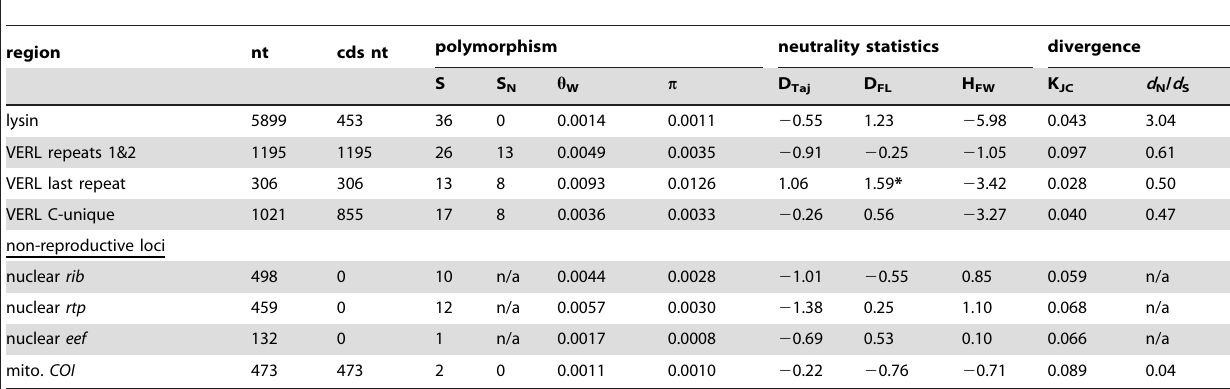
N=28 individuals. nt=nucleotides, cds=coding sequence, S=polymorphic sites, S N =nonsynonymous polymorphic sites, h W =Watterson’s theta, p =nucleotide diversity, D Taj =Tajima’s D, D FL =Fu & Li’s D, H FW =Fay & Wu’s H, an asterisk( * ) denotes statistical significance at a =0.05, K JC =Jukes-Cantor corrected distance to outgroup, d N / d S =nonsynonymous/synonymous divergence.